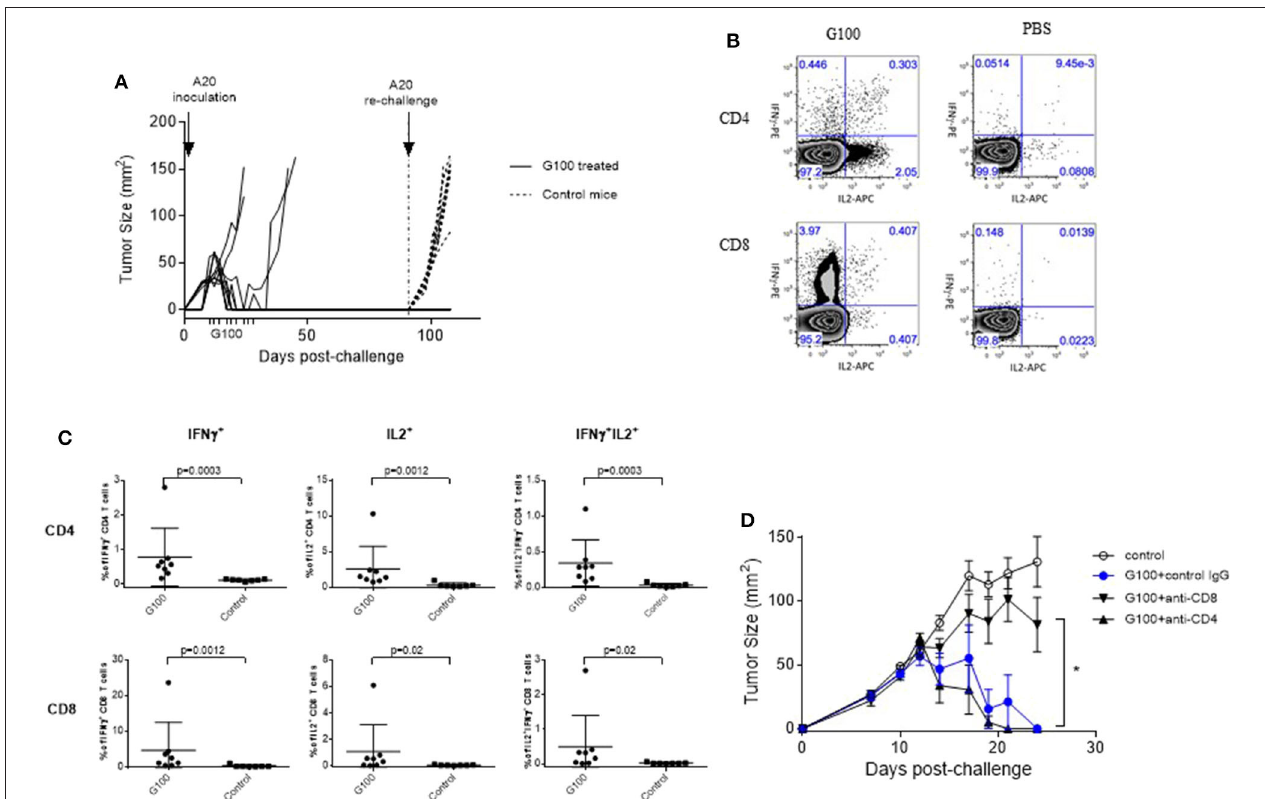
FIGURE 2 | G100 induces CD8T cell-mediated tumor protection and memory responses. (A) Rejection of A20 tumor re-challenge in G100-treated mice. On Day 7 after A20 tumor cell inoculation, mice with palpable A20 tumors started receiving GLA-SE treatment (10 µ g, 3x/week, for 3 weeks), as indicted on the x-axis. Six out of 10 treated mice had complete tumor regression and received a second tumor challenge on the opposite side of the original tumor at 3 months after the initial tumor inoculation (indicated by vertical dotted line on day 90). All these mice rejected the secondary tumor challenge, demonstrating the development of long-term immunity. Untreated mice developed tumor rapidly after A20 challenge, as shown in tumor growth curves with dotted lines. (B) Splenocytes were collected from G100-treated mice and naïve Balb/c mice ( n = 8 per group) and stimulated with irradiated A20 tumor cells at a 10:1 ratio with the addition of brefeldin A and cultured overnight. Then the cells were then either surface stained or permeabilized and stained with antibodies against IFN γ , IL2, and TNF α and analyzed by FACS. Shown are representative dot plots showing IL-2 and IFN γ production in CD4 and CD8T cells in splenocytes co-cultured with A20 tumor cells. For data analysis, cells were first gated as singlets based on FSC and SSC. Then the singlet cells were gated based on a viability dye. The live cells were gated for CD3 + T cells, which were further separated into CD4 and CD8T cells. (C) Summary graphs showing the levels of cytokine positive cells in CD4 and CD8T cells from GLA-treated or control naïve mice. (D) Tumor growth curves (mean ± sem) in mice that were treated with PBS, G100 (10 µ g GLA, 2%SE /mouse, 3 times/week for 3 weeks), or G100 plus CD4 or CD8T cell depletion. The depletion efficiency was more than 95% as measured by FACS (data not shown). Depletion of CD8T cells but not CD4T cells significantly abrogated the anti-tumor effects of G100. * p < 0.05 between G100 and G100 + CD8 depletion